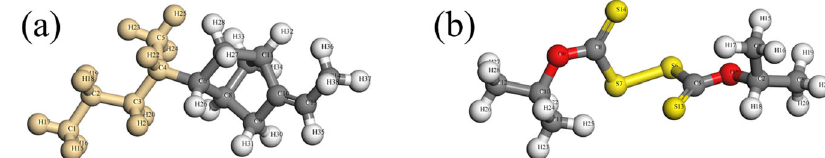
Fig. 8 Molecular structures. a EPDM and b DIP.